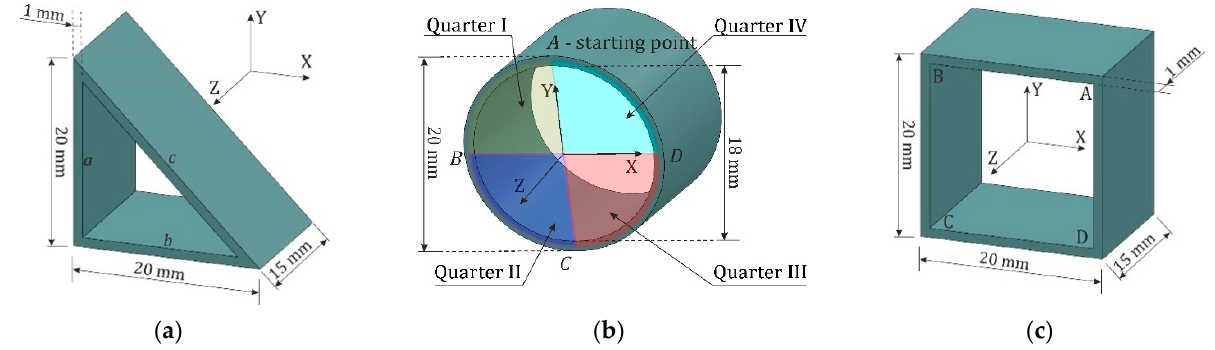
Figure 7. The objects printed during 3D printer tests: ( a ) trihedron, ( b ) tube, ( c ) tetrahedron.